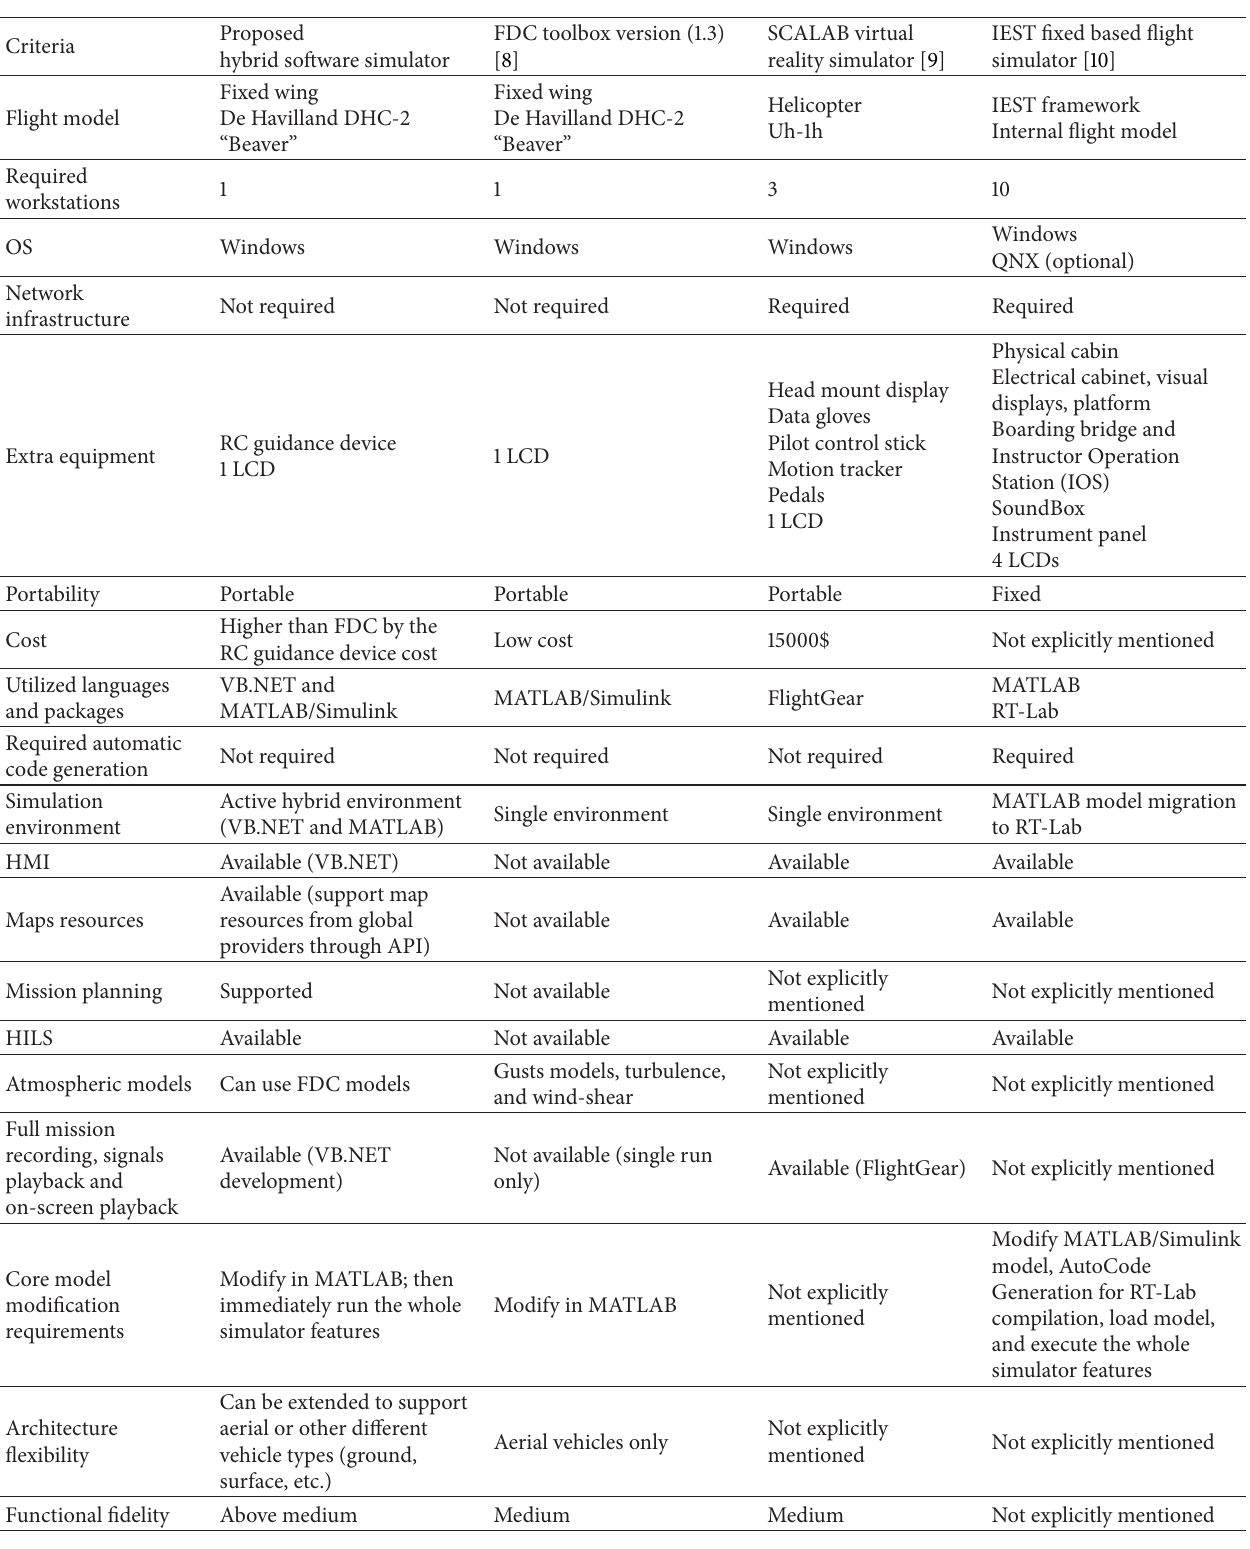
Table 3: Proposed hybrid simulator versus other different existing